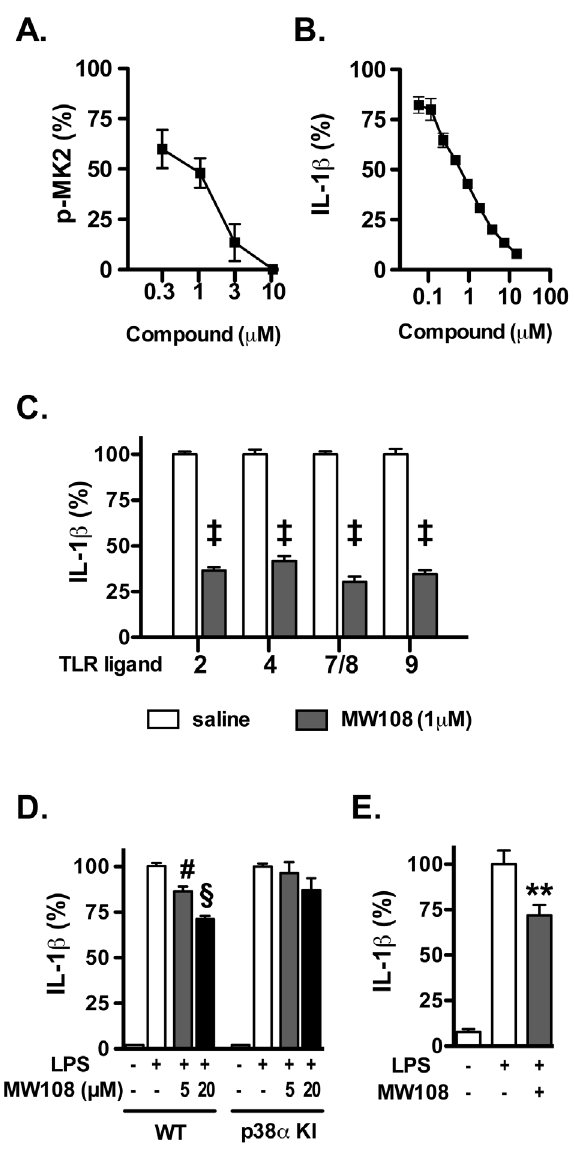
Figure 6. Cellular target engagement and mechanism of action of MW108. A. MW108 inhibited phosphorylation of the p38 a substrate MK2 in a concentration-dependent manner in LPS-stimulated BV-2 microglial cells. B. MW108 inhibited LPS-induced IL-1 b production in a concentration-dependent manner in BV-2 cells. C. MW108 suppressed IL-1 b production in BV-2 cells stimulated with diverse TLR ligands. BV-2 cells were treated with ligands for TLR2, TLR4, TLR7/8, and TLR9 in the absence (white bars) or presence (gray bars) of MW108. ` p , 0.0001 compared to TLR ligand in the absence of compound. D. MW108 inhibited LPS-induced IL-1 b production in primary microglia from wild-type (WT) mice, but not from drug-resistant p38 a MAPK knock-in (p38 a KI) mice. # p , 0.01, 1 p , 0.001 compared to LPS alone. E. MW108 suppressed LPS-induced IL-1 b levels in vivo . ** p , 0.01 compared to LPS alone (n= 6 saline/vehicle; n= 24 LPS/vehicle; n=15 LPS/MW108). Data in all panels are expressed as a percent of the maximal levels, where levels in the presence of stressor alone were normalized to 100%.